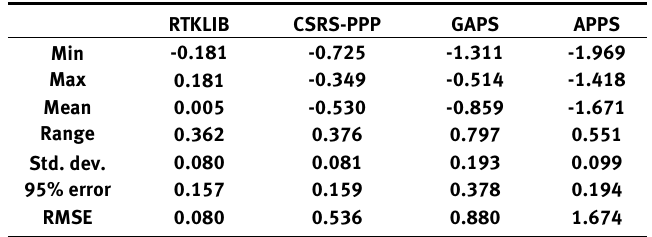
Table 6. Results about longitude differences (Pix4Dmapper)